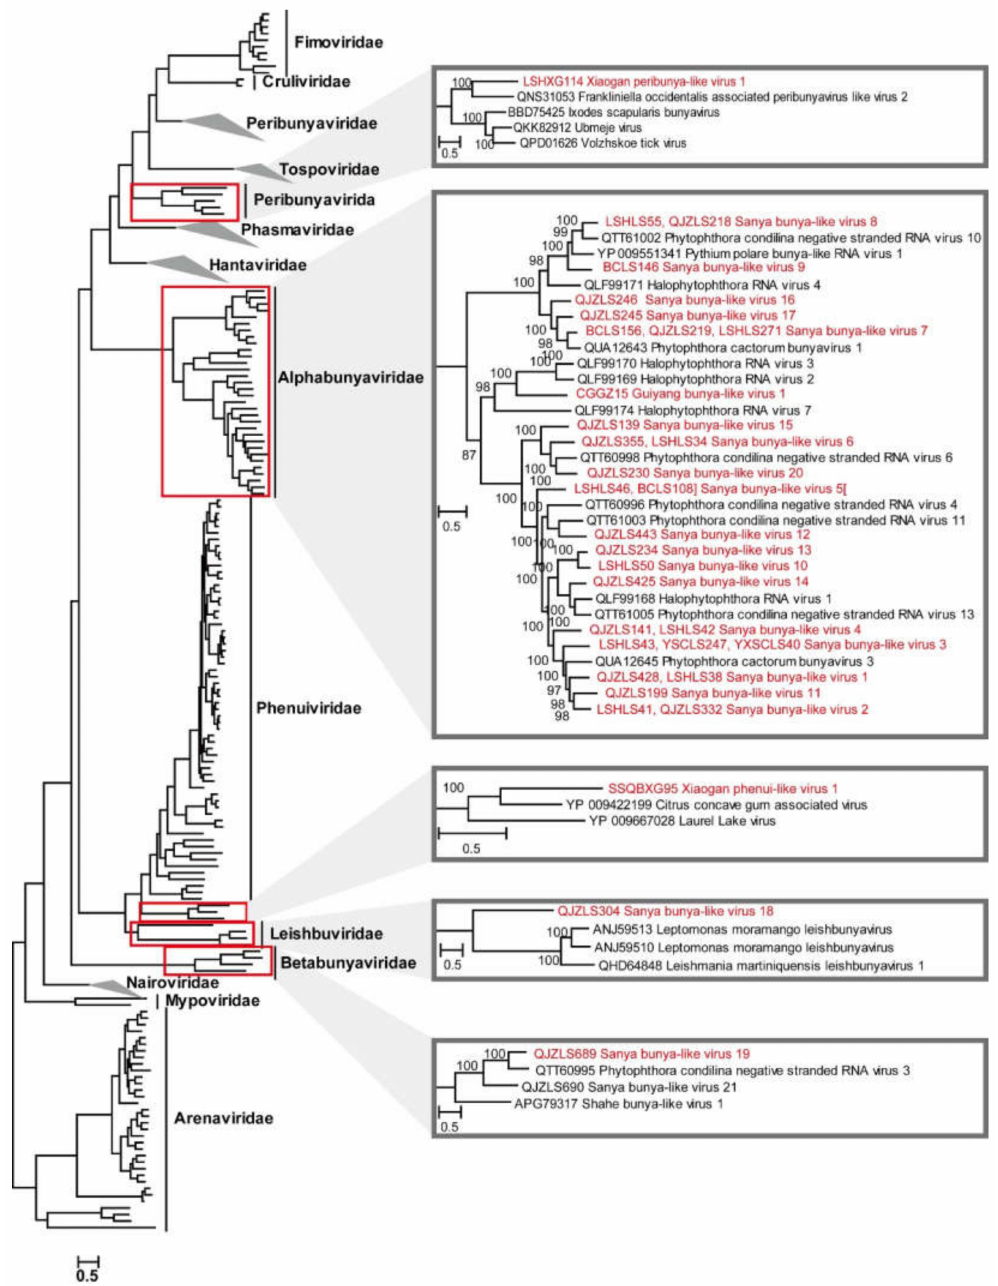
Figure 5. ML phylogenetic analysis of the order Bunyavirales. Phylogenetic trees were constructed using the aligned sequences of RdRp. The names of new viruses discovered in this study are marked in red, the names of known viruses discovered in this study are marked in blue, the reference virus serial numbers and names are marked in black and the families and genera of viruses (and branches in minimized trees) in this study are marked in bold. The red box represents the clade of the virus identified in this study. The grey triangle represents the enlarged part of the red